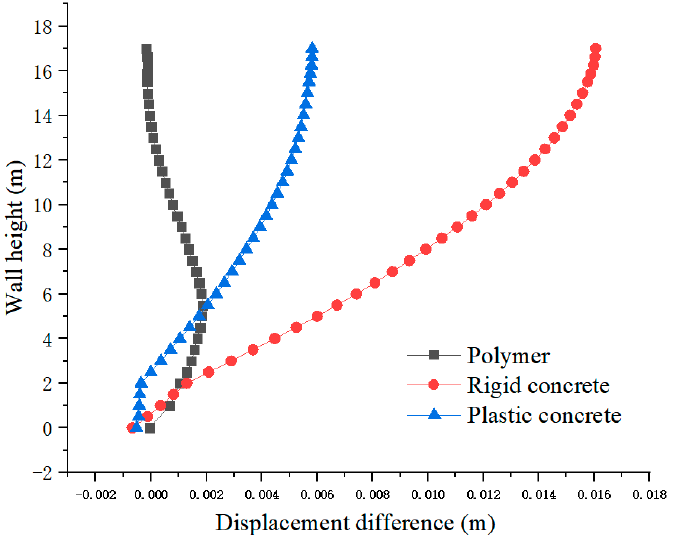
Figure 7. Comparison of displacement difference of anti-seepage walls with different materials along the